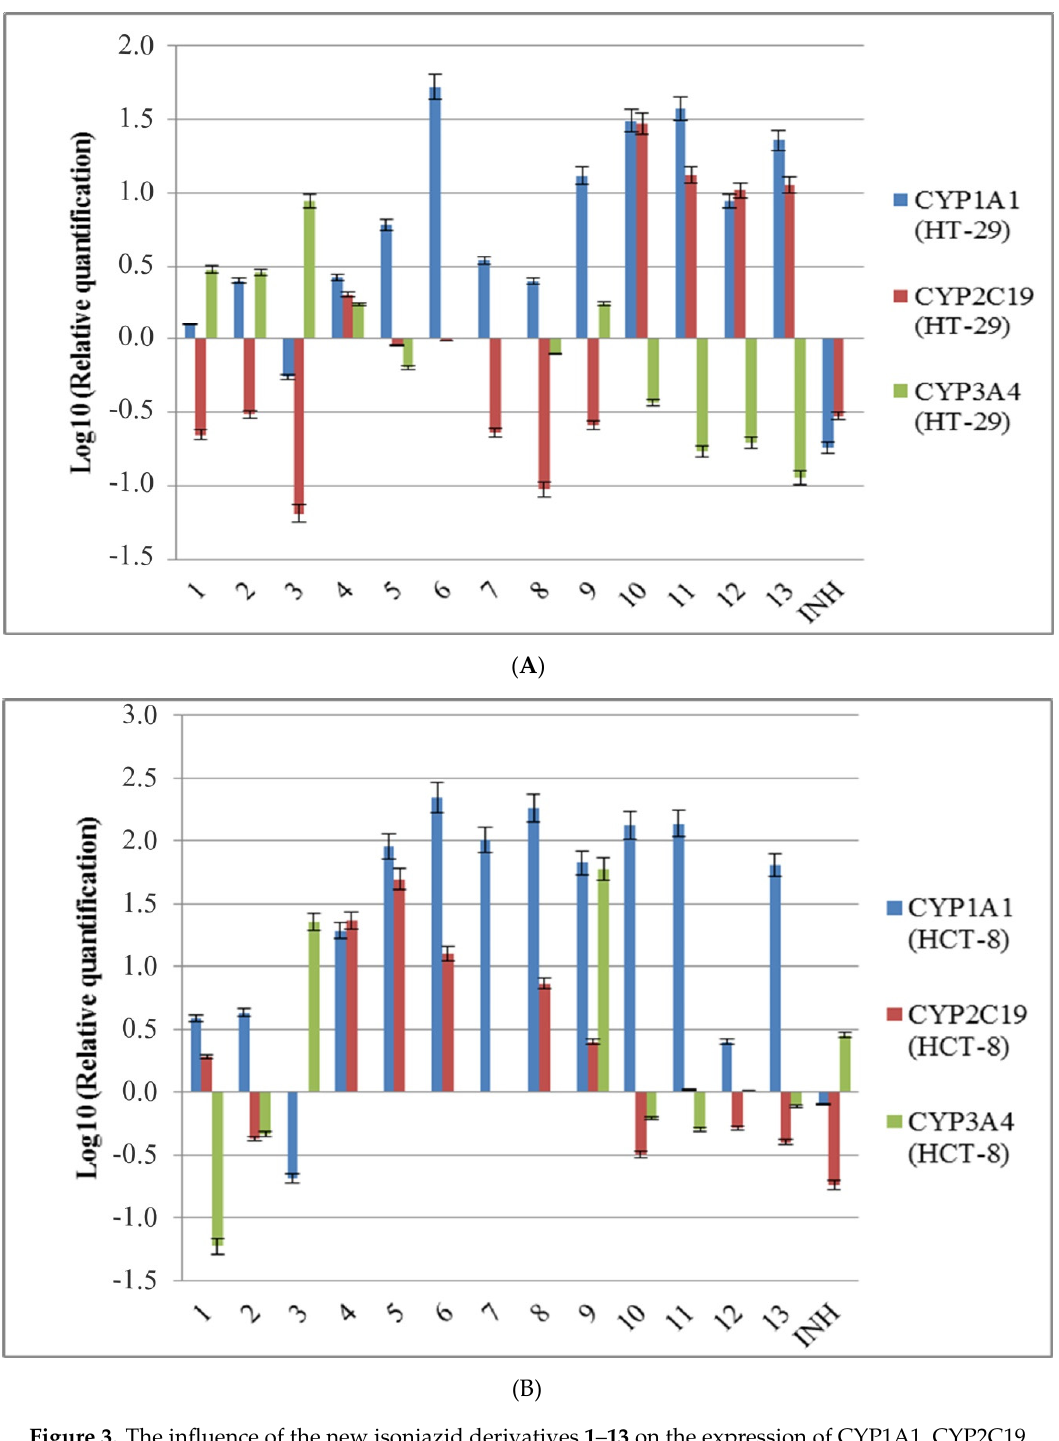
Figure 3. The influence of the new isoniazid derivatives 1 – 13 on the expression of CYP1A1, CYP2C19, and CYP3A4 genes in the eukaryotic cells; ( A ) HT-29 cells; ( B ) HCT-8 cells Isoniazid inhibits CYP2C19 and CYP3A4 activities and mechanistically inactivates CYP1A2 , CYP2A6 , CYP2C19 , and CYP3A4 in human liver microsomes [52,53]. El Sayed’s group analyzed